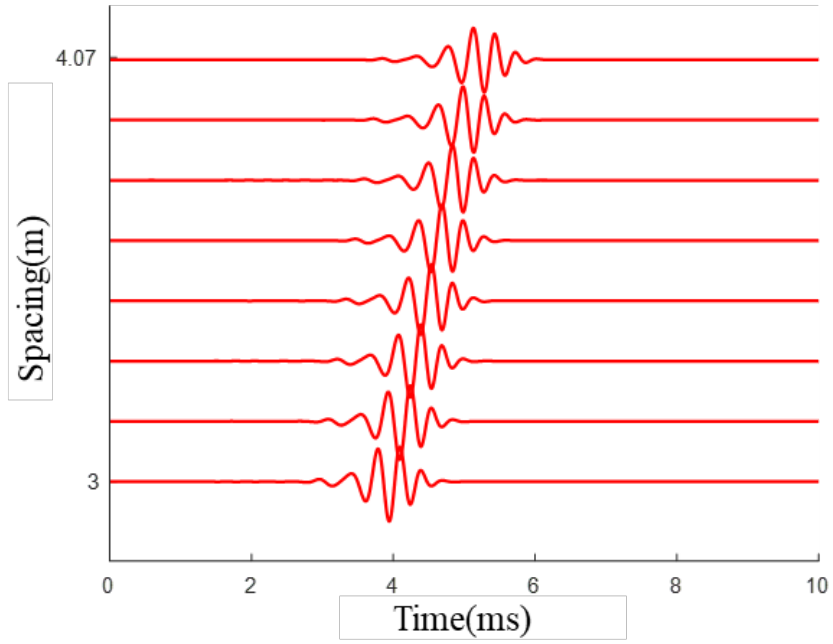
Figure 2. Waveforms of the numerical simulation model.